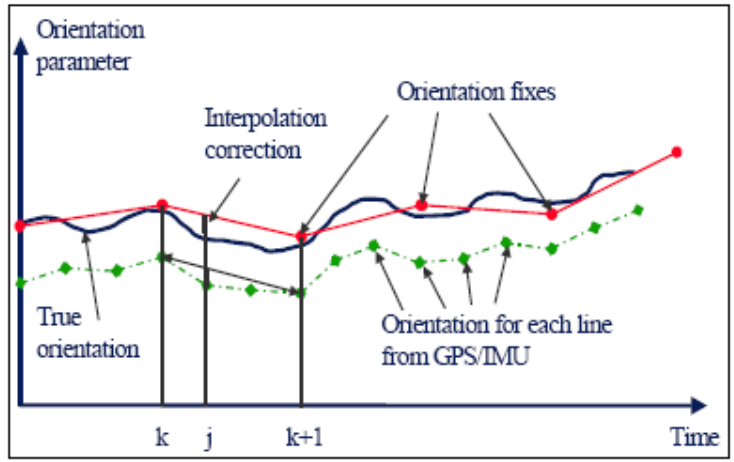
Figure 1. Example of one orientation parameter over time